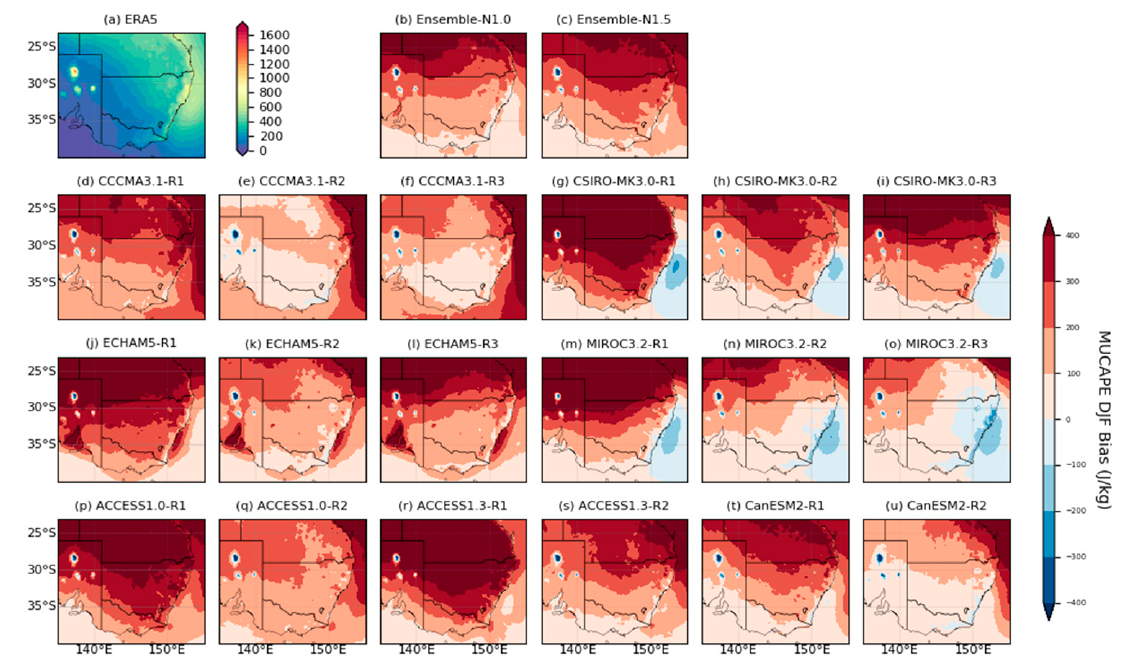
Figure A25. As in Figure A21 except for MUCAPE. Unit: J kg − 1 .